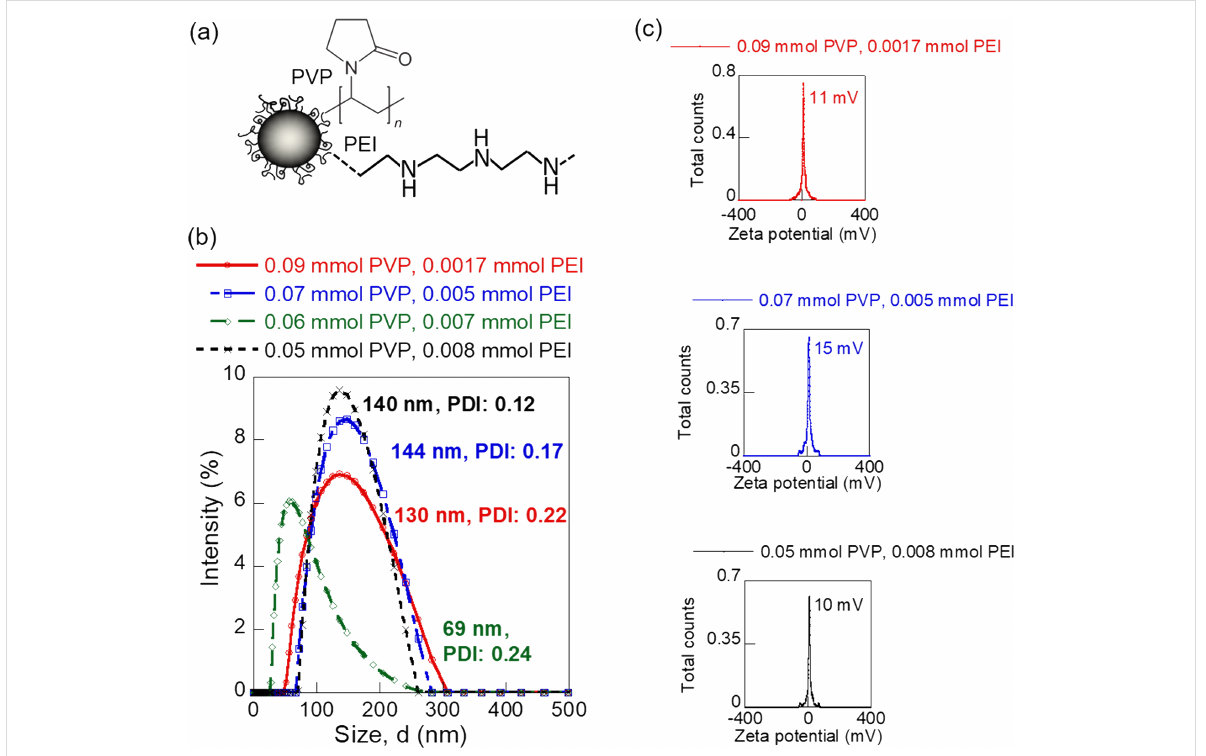
Figure 5: Different iron oxide NPs synthesized for the flow experiments. (a) Schematic overview, (b) hydrodynamic size plots, and (c) zeta potential plots.